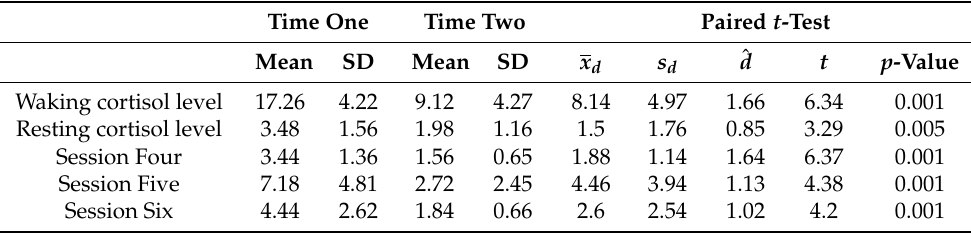
Table 6. Paired sample t -test results summary for Time One (pre-program or pre-session) and Time Two (post-program or post-session) *.